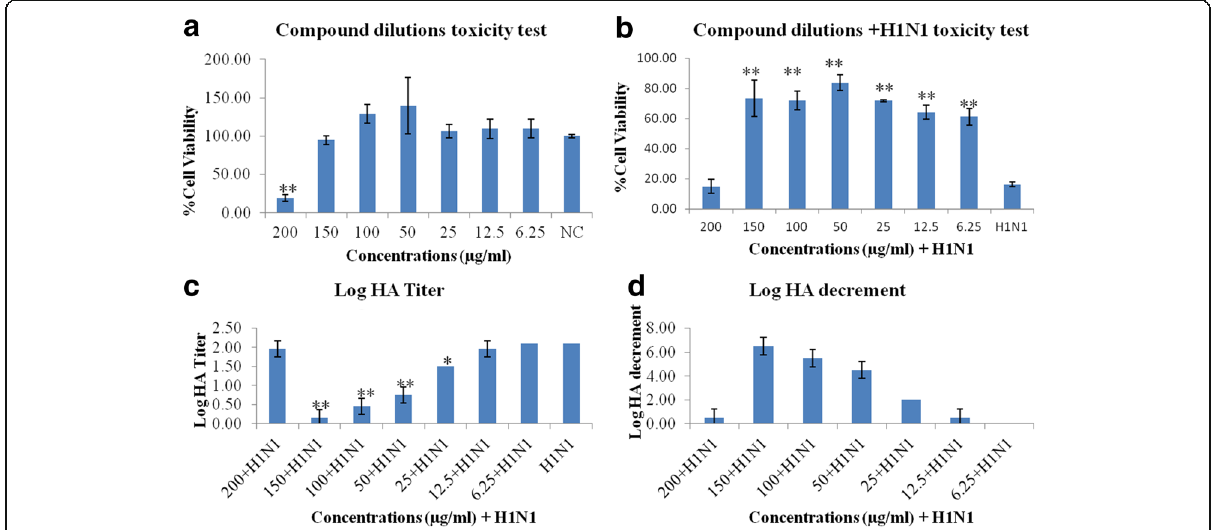
Fig. 2 Dose-dependent antiviral response. Compound dilutions toxicity ( a ), Compound dilutions + H1N1 toxicity ( b ), Log HA Titer ( c ) and Log HA decrement ( d ). * & ** show the significant and highly significant differences compared to control,